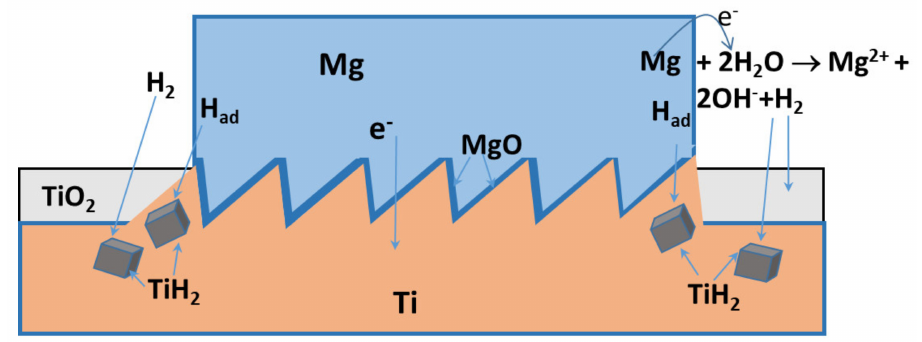
Figure 10. Possible scheme of loading of hydrogen (H ad and H 2 ) into the titanium